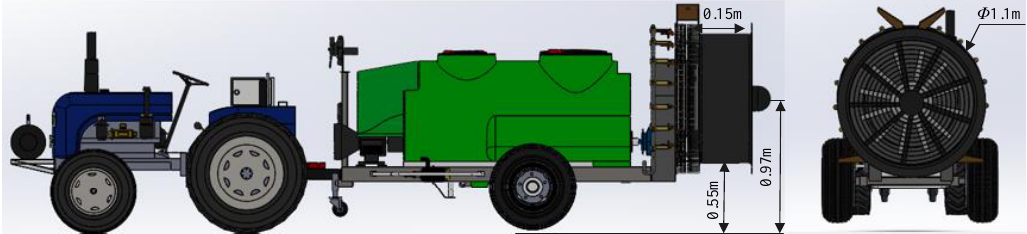
Figure 1. 3WQF-1000 traction air-assisted orchard sprayer.